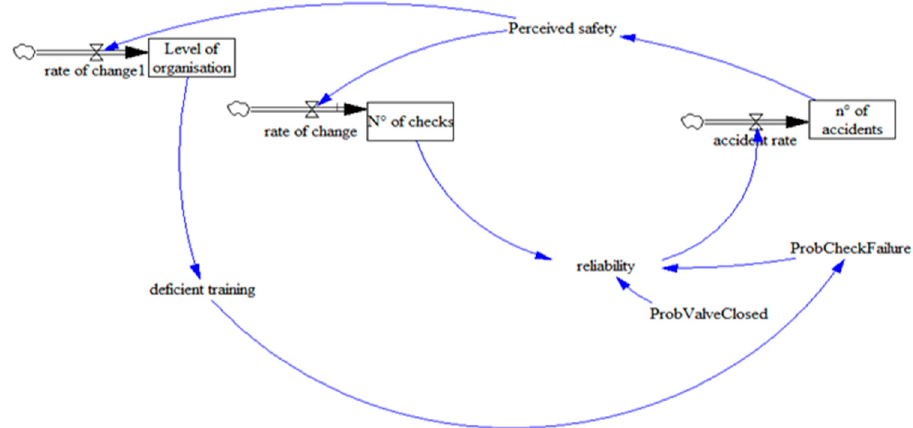
Figure 18. Sample schematic showing time and state affecting reliability.